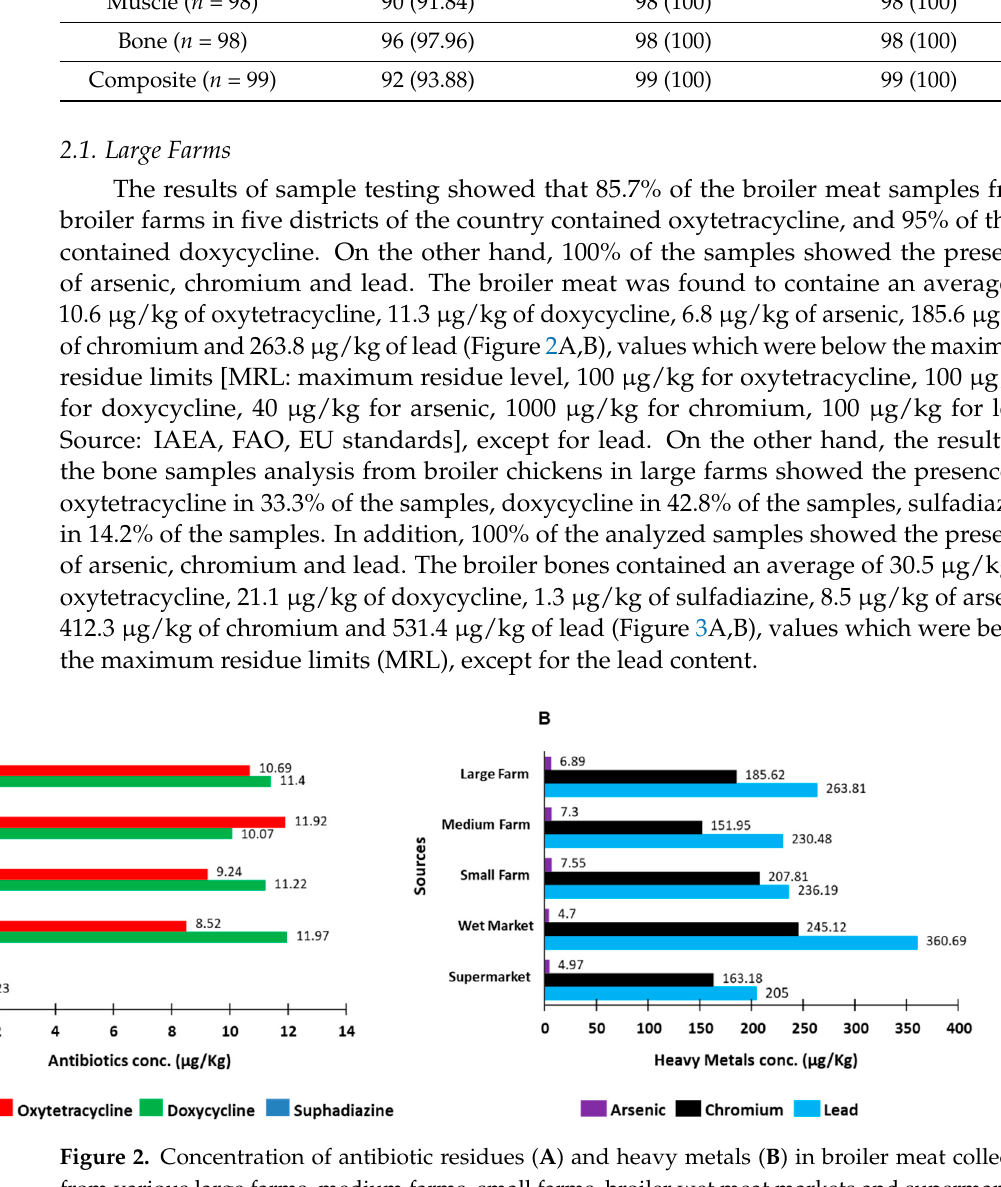
Table 2. Overall percentages of different heavy metals residue in different parts of the broiler body.